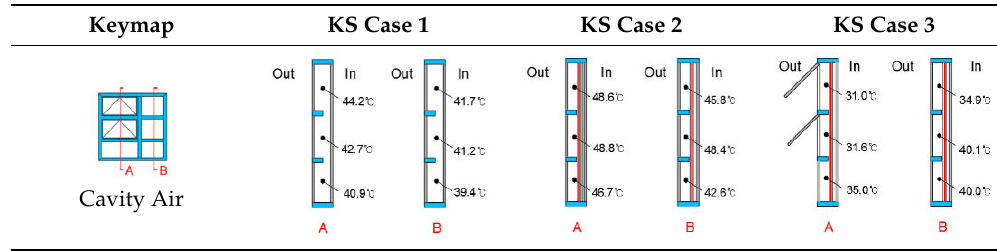
Table 6. Cavity air temperature distributions of KS Cases 1, 2, 3 in SHGC